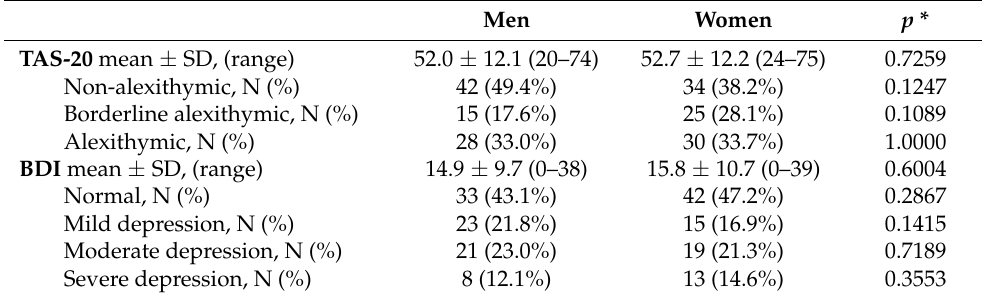
Table 5. TAS–20 and BDI scores in men and women of AD group.